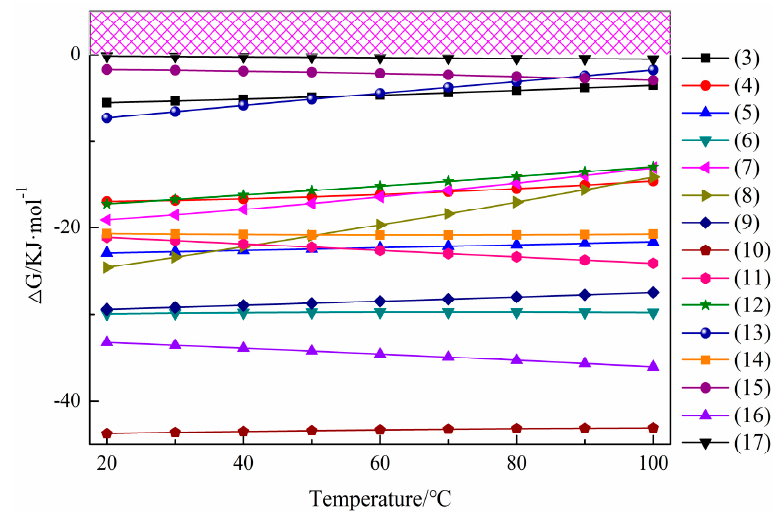
Figure 3. Relationship of functions’ Δ G vs. T in acid leaching process.